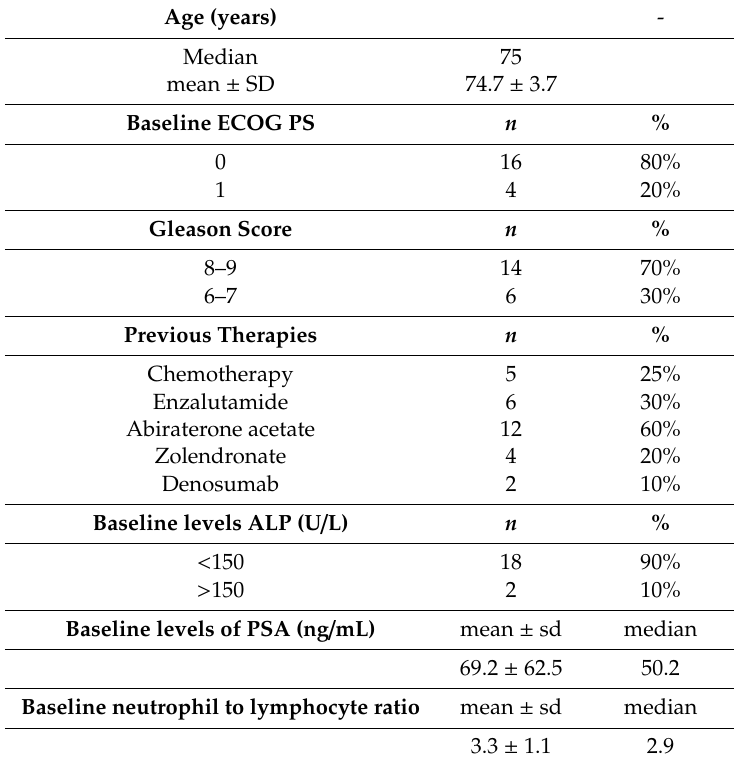
Table 1. Patients’ clinical-demographic features and results of quantitative